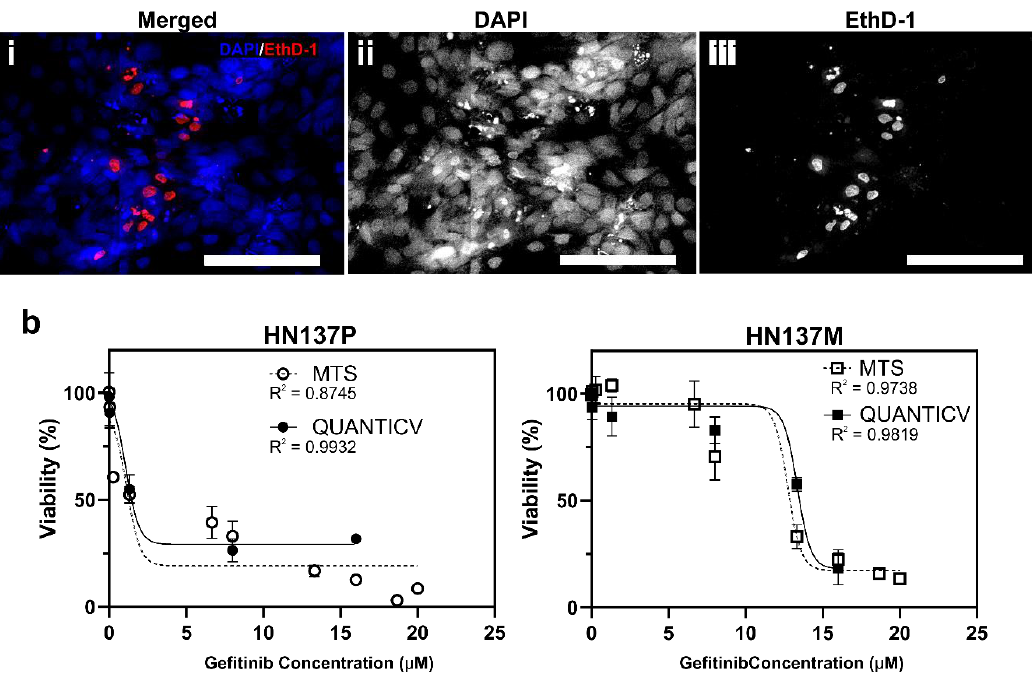
Figure 2. Validation of the QuantICV assay against the MTS assay in two-dimensional (2D) cultures of parental (HN137P) and metastatic (HN137M) OSCCs. ( a ) Confocal fluorescent images showing nuclei staining of dead (EthD-1) and total (DAPI) cell populations in 2D oral squamous cell carcinoma (OSCC) cultures. Images presented were selected from a stitched, tiled image across multiple sections of the culture well presented in Supplementary Figure 3a. Scale bars = 100 µm. ( b ) Quantification of cell viabilities in parental and metastatic HN137 cells after treatment with various Gefitinib concentrations using the MTS assay (solid line) and QuantICV assay (dotted line). Data are averages of n = 3 repeats with ± deviation (SD).